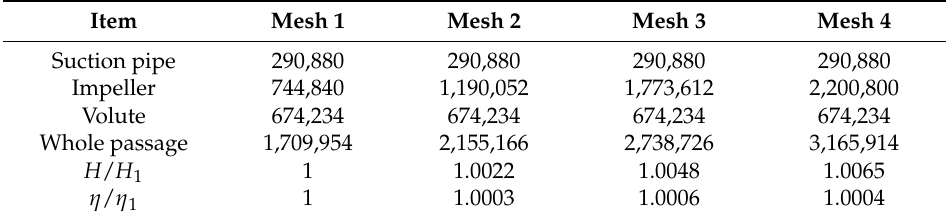
Table 2. Pump head H and efficiency η versus mesh elements.